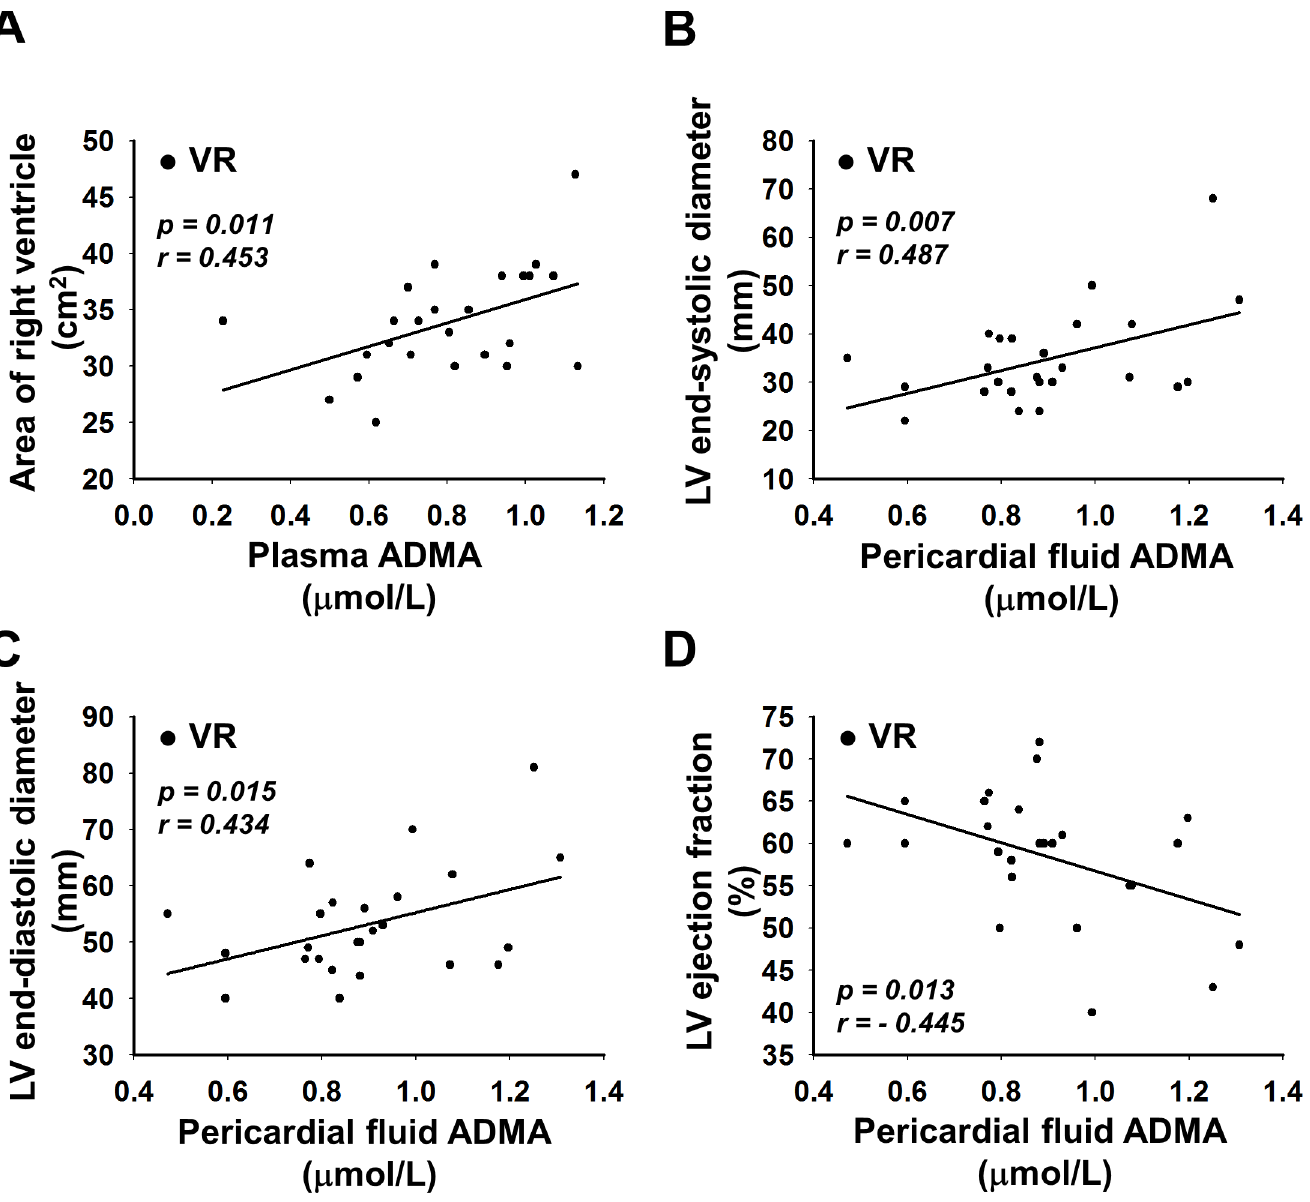
Fig 4. Correlations between the levels of asymmetric dimethylarginine (ADMA) and echocardiographic parameters of patients undergoing valve replacement (VR) surgery. (A) plasma ADMA vs. area of right ventricle ( y = 10.438 x + 25.49, r = 0.453, p = 0.011); (B) PF ADMA vs. left ventricular (LV) end-systolic diameter ( y = 23.689 x + 13.53, r = 0.487, p = 0.007); (C) PF ADMA vs. LV end-diastolic diameter ( y = 20.531 x + 34.72, r = 0.434, p = 0.015); D: PF ADMA vs. LV ejection fraction ( y = -16.779 x + 73.55, r = -0.445, p =